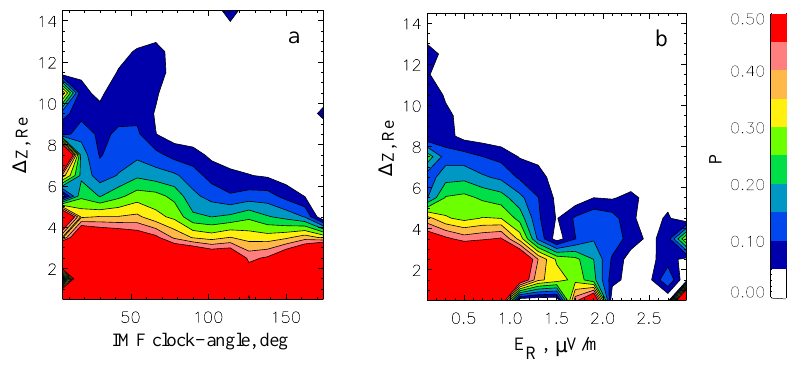
Fig. 10. (a) Color-coded distribution of probability P to observe PS-like struc- tures versus 1Z and IMF clock-angle. (b) The same versus 1Z and reconnec- tion electric field E R = | V sw × B IMF |· ) ; here, V sw is the solar wind sin 4 ( 2 2 velocity, B IMF is the IMF, and 2 is the IMF clock-angle. The E R is marked in microvolts per